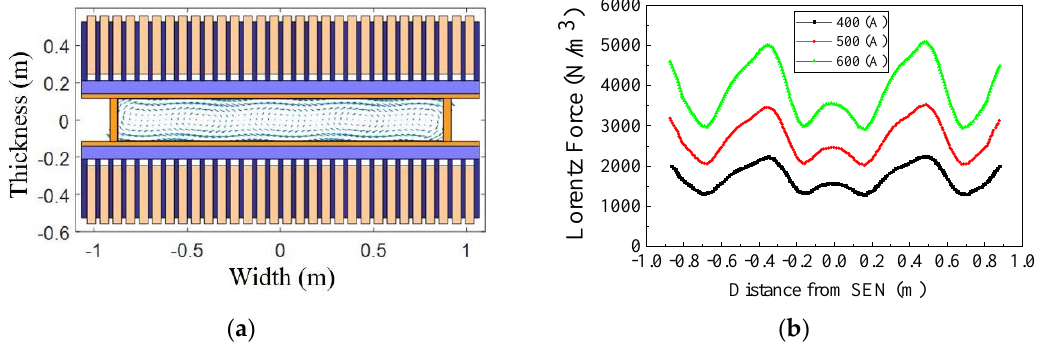
Figure 4. ( a ) Distribution of Lorenz forces on the horizontal cross-section at the central level of electromagnetic stirring (EMS). ( b ) Distribution of Lorenz forces along the wide face of the mold at different currents.